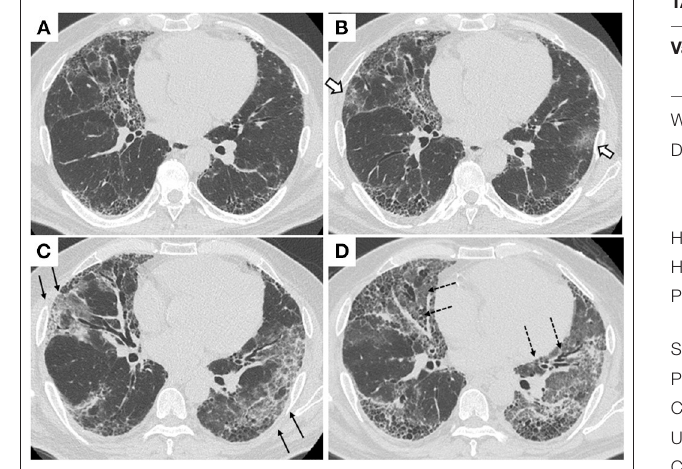
TABLE 1 | Blood test findings of the